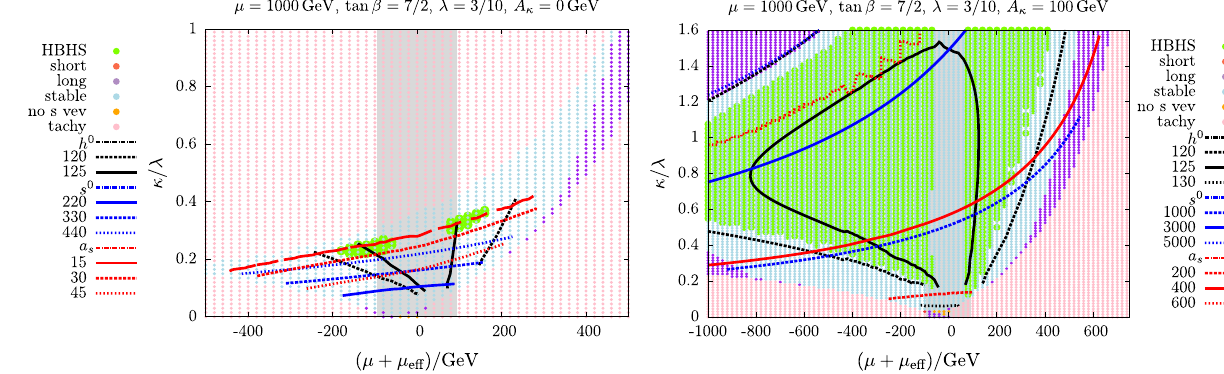
Fig. 6 The same as Fig.4 but for μ = 1000GeV, tan β = 3 . 5 and λ = 0 . 3